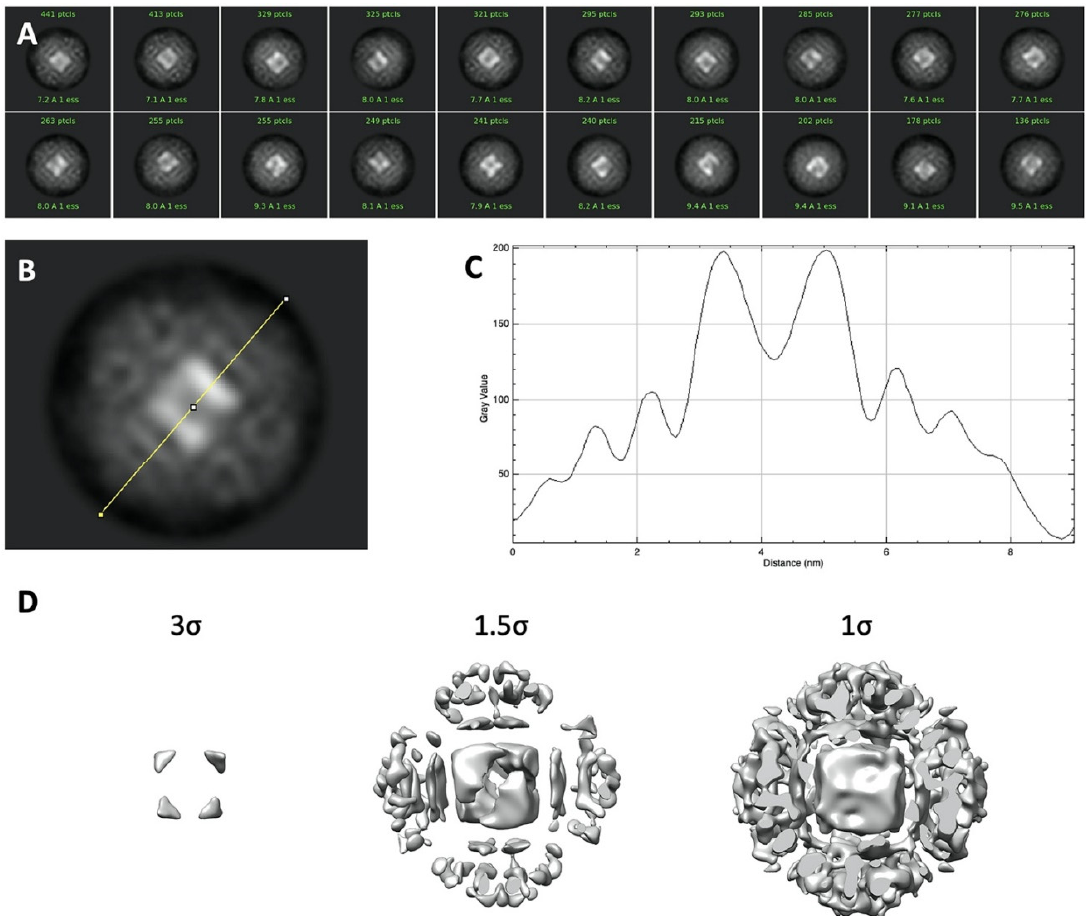
Figure A1. Class averages of Dps dodecamers with an estimated iron loading of between 50–2000 atoms (left to the right) after 3h incubation showing different morphologies of the iron cluster. Each of 2D class averages is 12.5 nm wide.